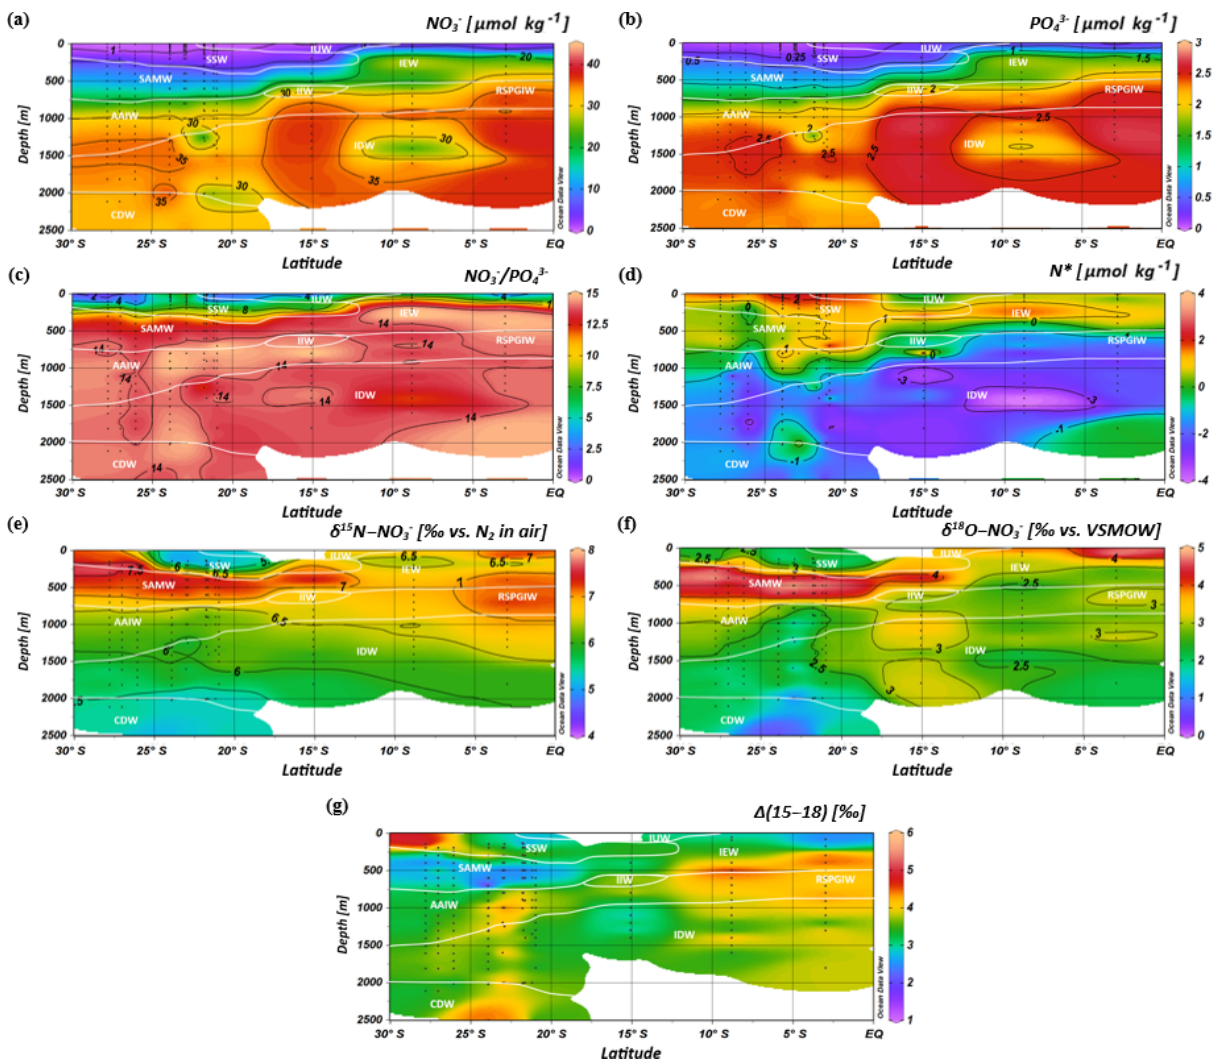
Figure 7. Latitudinal profiles from south to north with an overlay of the water mass distribution model (white contour lines) in the southern Indian Ocean for nitrate (a) and phosphate (b) concentrations, the NO − (f) and nitrate (cid:49) (15–18) as the difference between δ 15 N–NO −